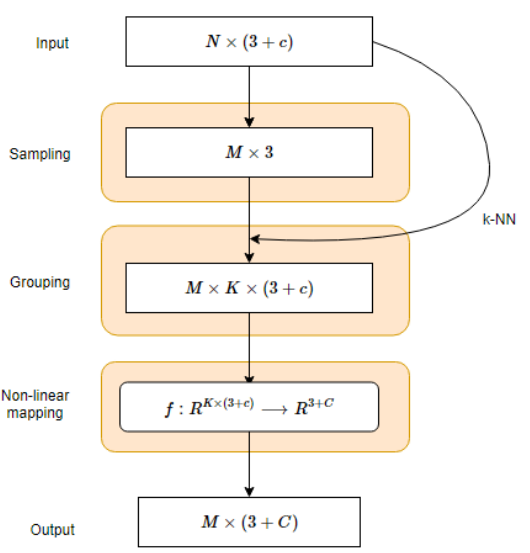
Figure 7. Basic operations for capturing local structures in a point cloud. Given P ∈ R N × ( 3 + c ) points, each point is represented by XYZ and c feature channel (for input points, c can be point features such as normals, RGB, etc or zero). M (cid:54) N centroids points are sampled from N , and k-nearest neighbor (kNN) points to each of the centroids are selected to form M groups. Each group represents a local region (receptive field). A non-linear function, usually approximated by a PointNet-based MLP, is then applied to the local region to learn the C–dimensional local region features ( C (cid:62) c